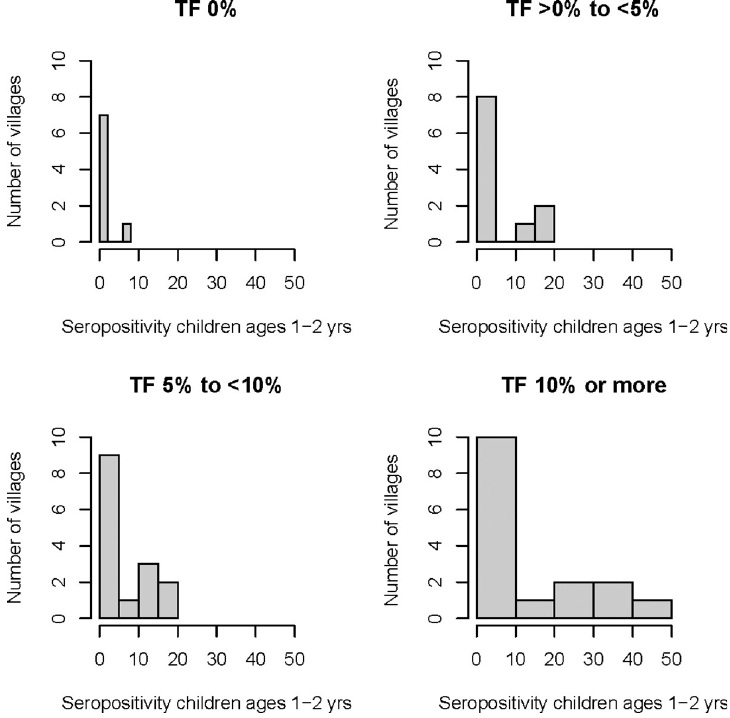
Fig 4. Number of villages with various percent seropositivities in children ages 1–2 years, categorized by overall village-level TF prevalence in children ages 1–9 years.